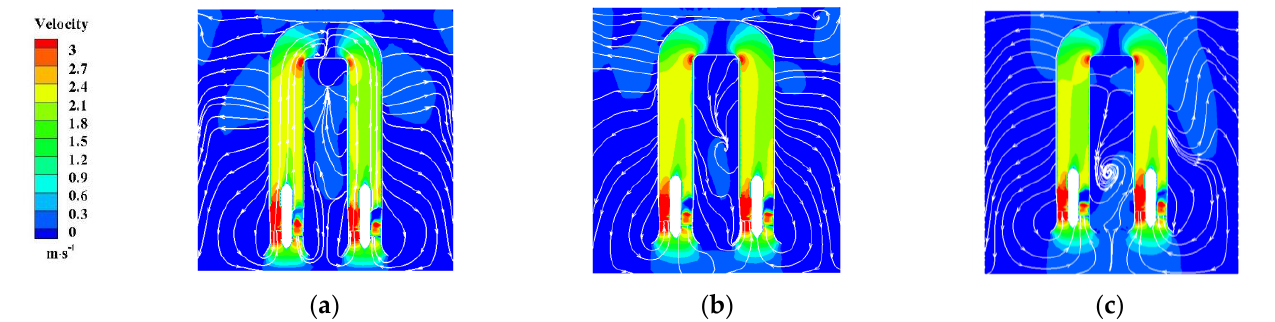
Figure 14. Streamline and velocity distribution nephogram of Section 1-1 under different H values: ( a ) H = 0.3 D ; ( b ) H = 0.6 D ; ( c ) H = 0.9 D.